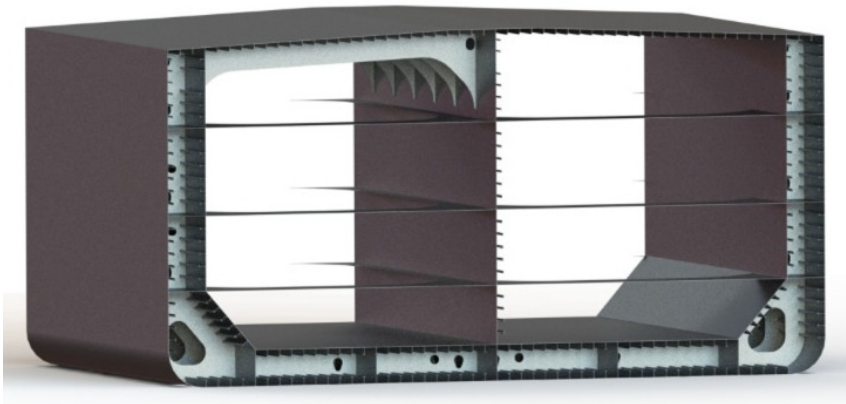
Figure 1. Midship construction.